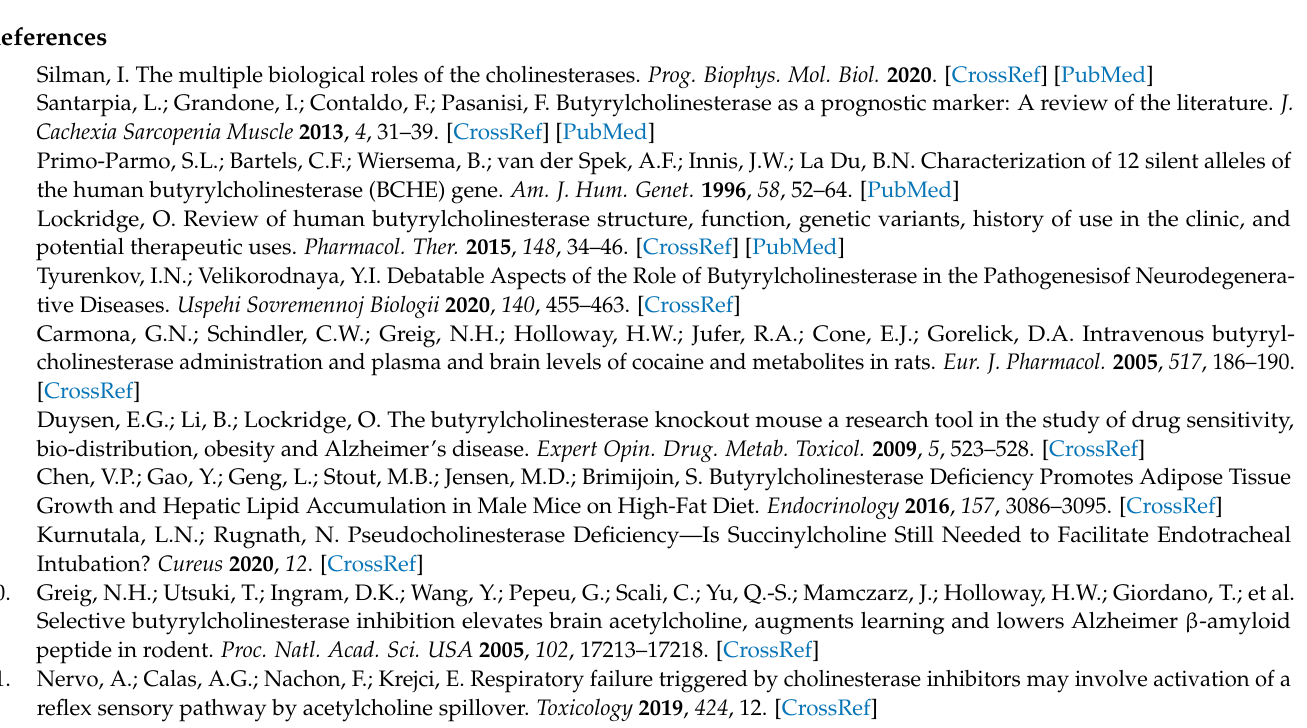
mice, Figure S3: Inhibition of BChE enzyme activity rescued the age-related vitality decline in mice, Figure S4: The results of the open field experiment after fear conditioning, Figure S5: Inhibition of BChE enzyme activity shortened the immobility time of mice in forced swimming